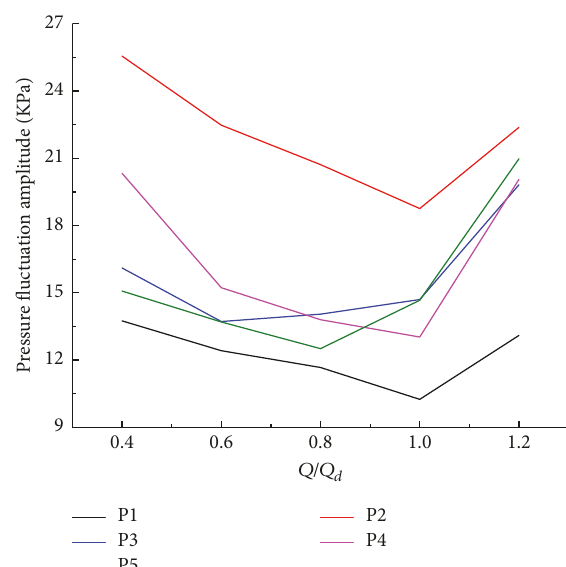
Figure 8: Pressure fluctuation amplitude of each monitoring